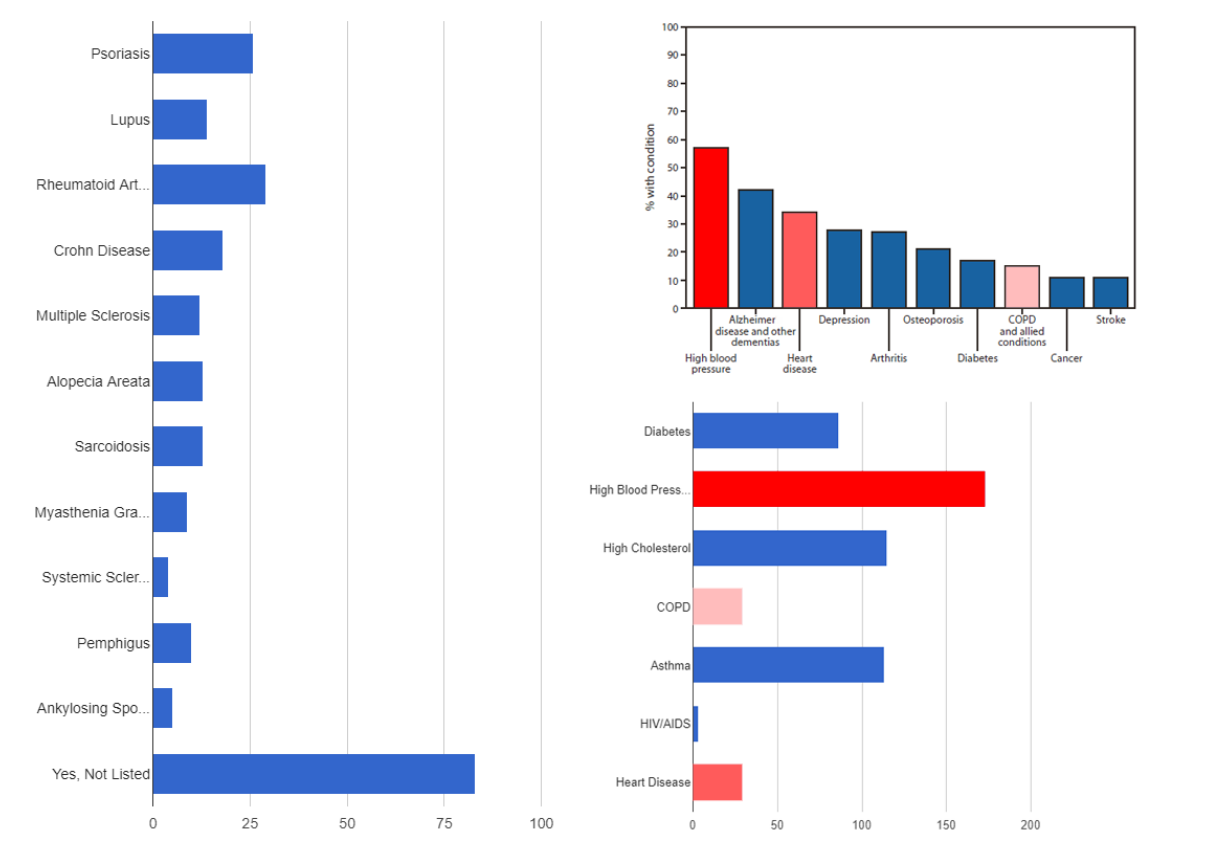
Figure 2. Total number of survey participants that indicated they have either a chronic health condition (n=390) or an autoimmune disorder that may increase susceptibility and risk to COVID-19 infection (n=169), and subsequent morbidity and mortality, in comparison to the ten most common chronic health conditions among persons living in residential care facilities (as of the national survey of residential care facilities in the United States in 2010), published by the Centers for Disease Control and Prevention on August 10, 2012, as reported by Caffrey et al (upper right). Darker red corresponds to the most common and lighter red to the least common chronic health conditions. COPD: chronic obstructive pulmonary